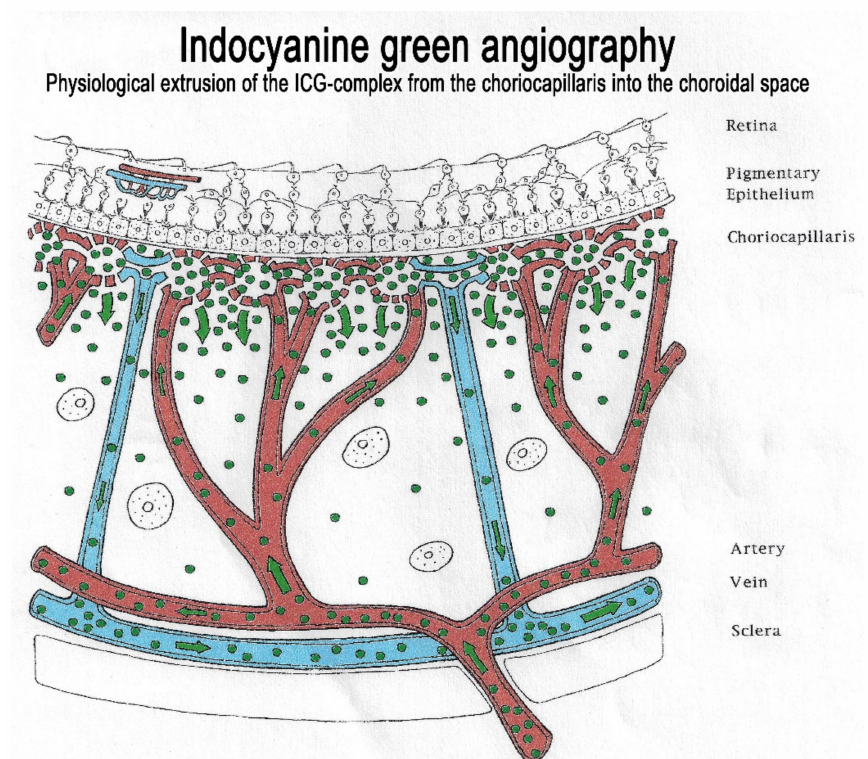
Figure 2. Indocyanine green angiography (ICGA). The ICG-protein complex remains intravascular in retinal vessels rendered impermeable by tight-junctions and in the large choroidal vessels but extrudes freely from the fenestrated choriocapillaris and impregnates progressively the choroidal stroma. It is these intermediate and late angiographic phases that are important for the evaluation of